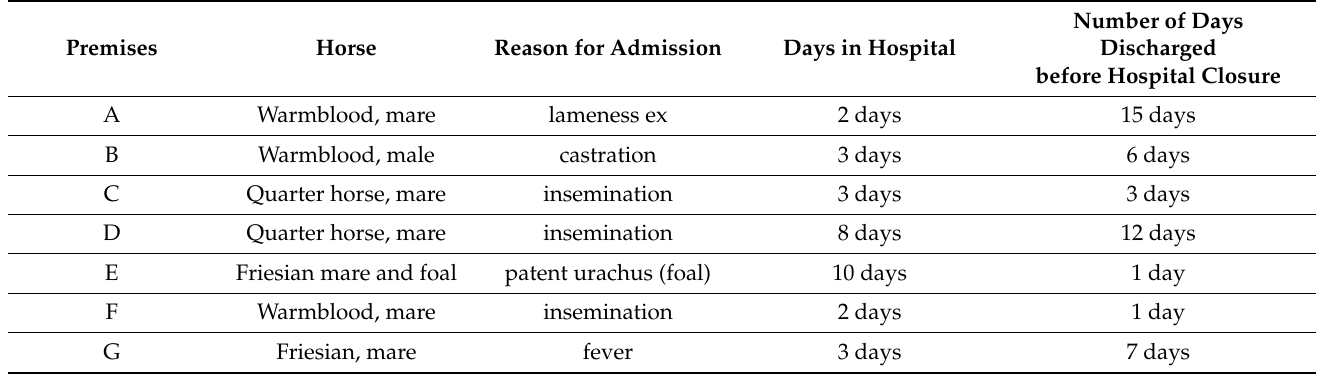
Table 1. List of possible case 1